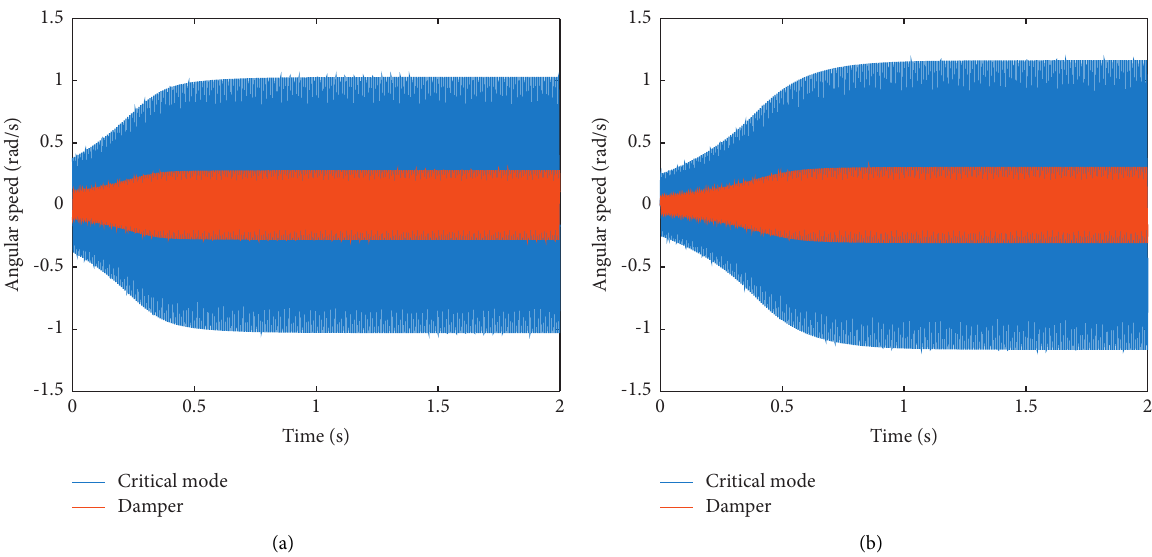
Figure 4: Time response of the damper (physical) and structure (modal) without shocks, using a CMS-reduced model (a) and a modal- reduced model